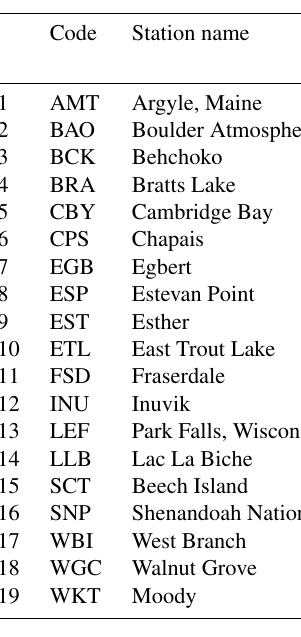
Table 2. Experiment design. n/a – not applicable